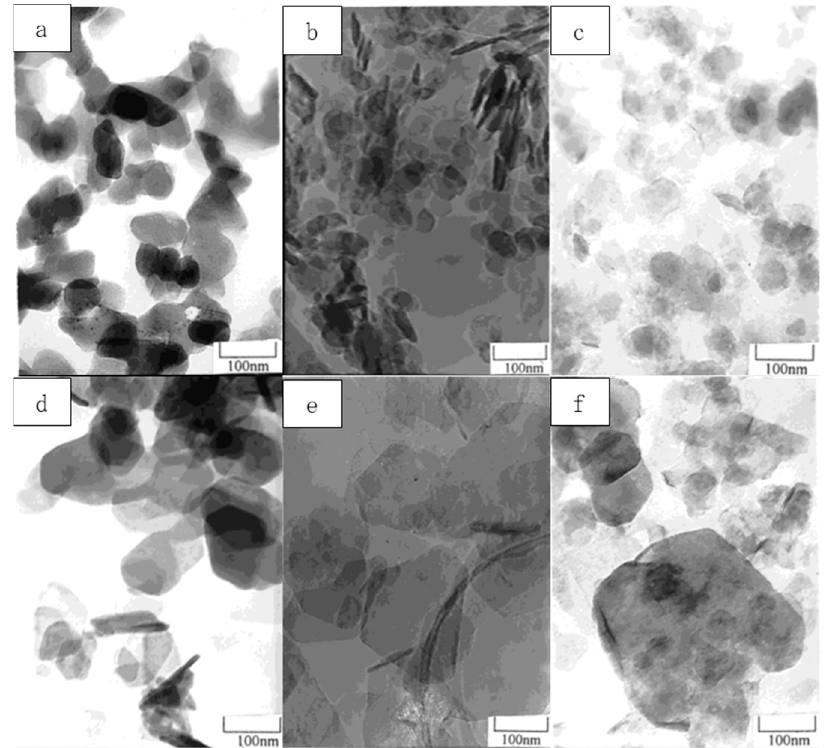
Figure 4. TEM images of MgAl-LDHs prepared by co-precipitation using colloid mill ( a – c ) and by conventional co-precipitation without colloid mill ( d – f ) (at the molar Mg:Al ratio of 2 ( a , d ), 3 ( b , e ), and 4 ( c , f ). Reproduced with permission from reference [88].